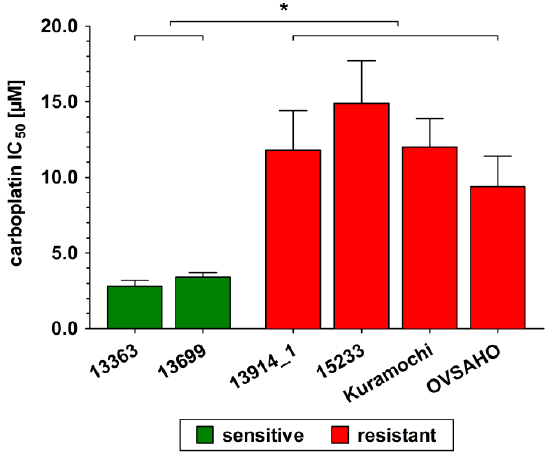
Figure 1. Sensitivity of all investigated high-grade serous ovarian cancer (HGSOC) cell lines in response to carboplatin. Cells were incubated in the presence of increasing carboplatin concentrations (0 to 50 µ M) for 72 h and the remaining viable cells were determined using a CASY ® TT cell counter. Green color indicates sensitivity and red color indicates resistance against carboplatin to the respective cell line. All data are presented as the means ± SD of three independent experiments. * p < 0.05.